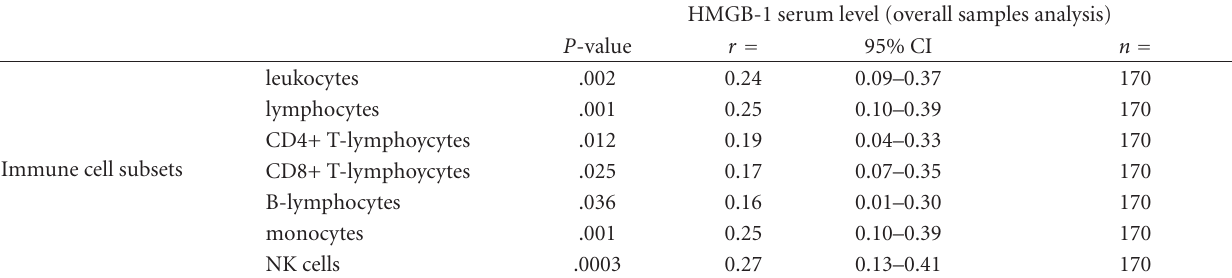
Table 3: Correlation table of systemic HMGB-1 levels with absolute numbers of immune cell